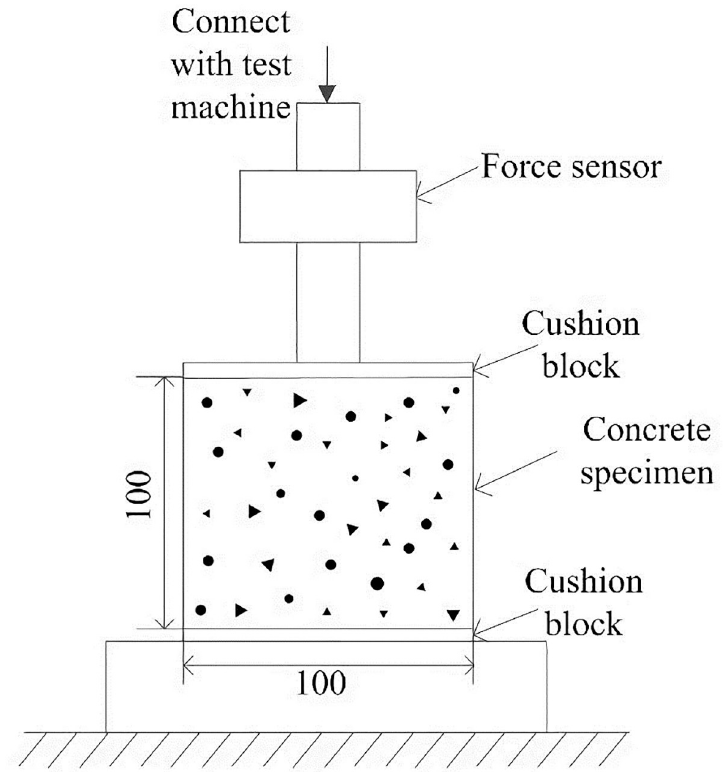
Fig 8. Concrete uniaxial compressive test device [31]. The compressive stress on the bonding interface is regarded as uniform distribution in this device.